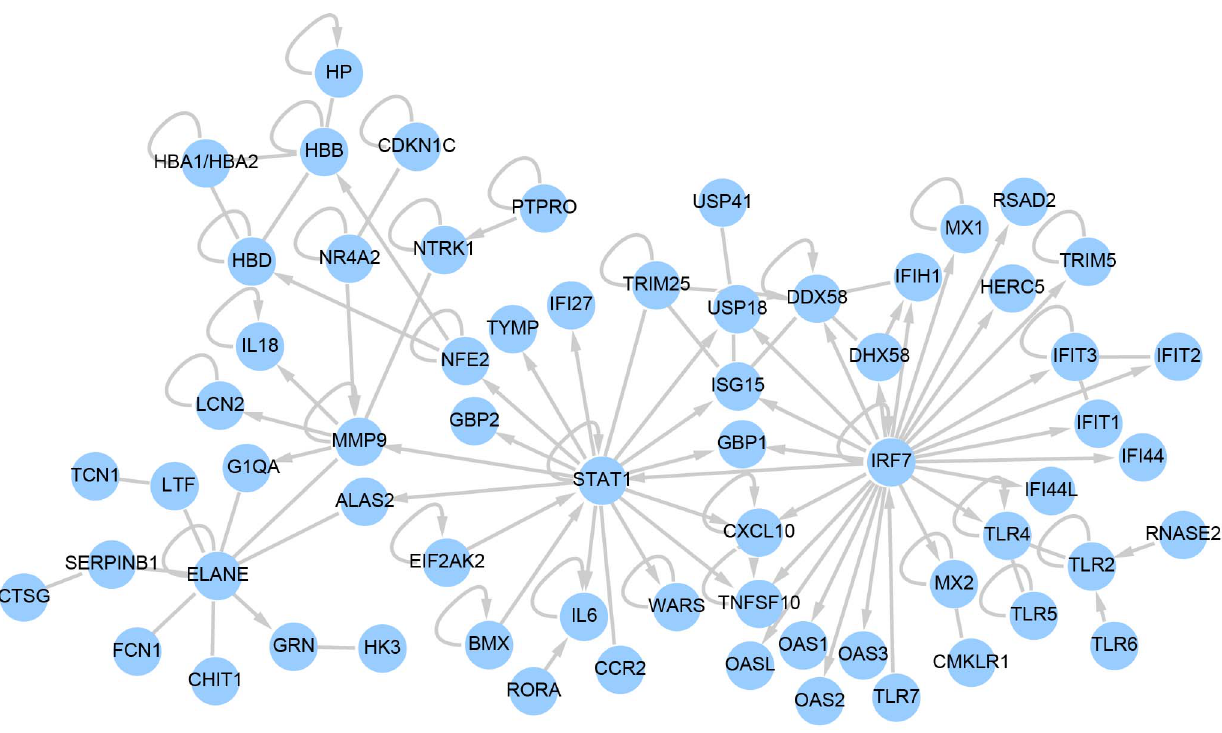
Figure 3. A signaling networks of 65 genes which are strongly upregulated following LASV challenge of NHP. Ingenuity Pathway Analysis software was used to analyze a list of 360 genes which were found to be strongly upregulated following LASV challenge. Of this list, 65 were found to be directly or indirectly connected according to Ingenuity’s database of published interactions. Nodes represent individual gene products, with official gene symbols included. Edges without arrows indicate a direct interaction between two gene products, e.g. a protein-protein interaction. Edges with arrows represent a regulation of transcription, directed from the gene regulator to a regulated gene. Loops indicate self-regulation. Notable in the expression profiles is the upregulation of STAT1 and IRF7, MMP9 and ELANE signaling